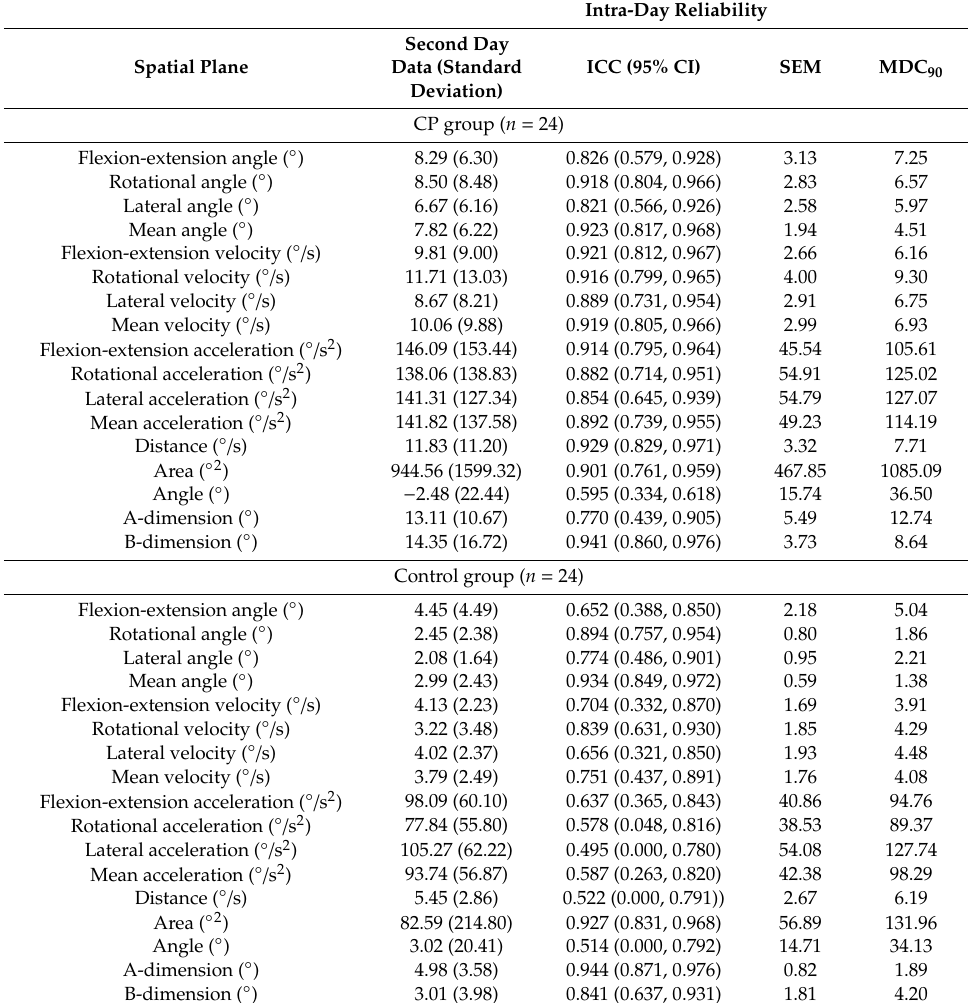
Table 5. Test–retest reliability of the new test